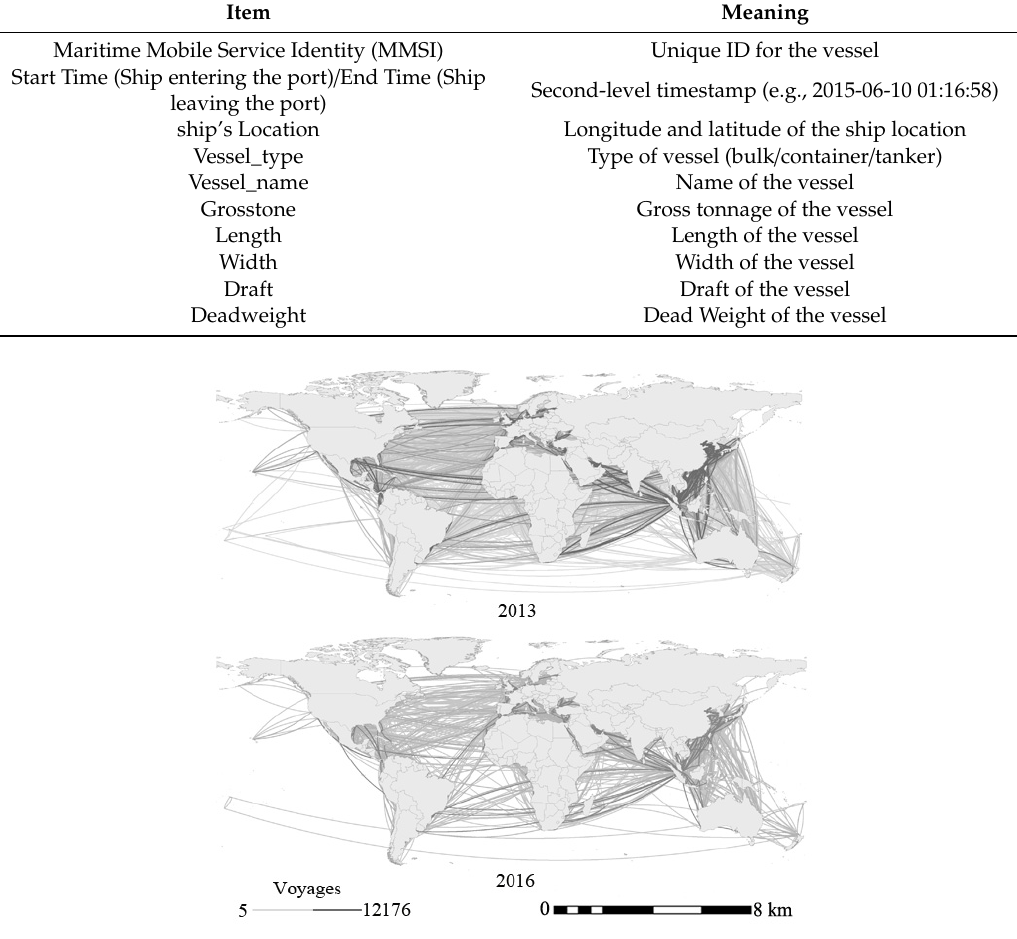
Figure 4. Global maritime network derived from AIS data in 2013 and 2016.